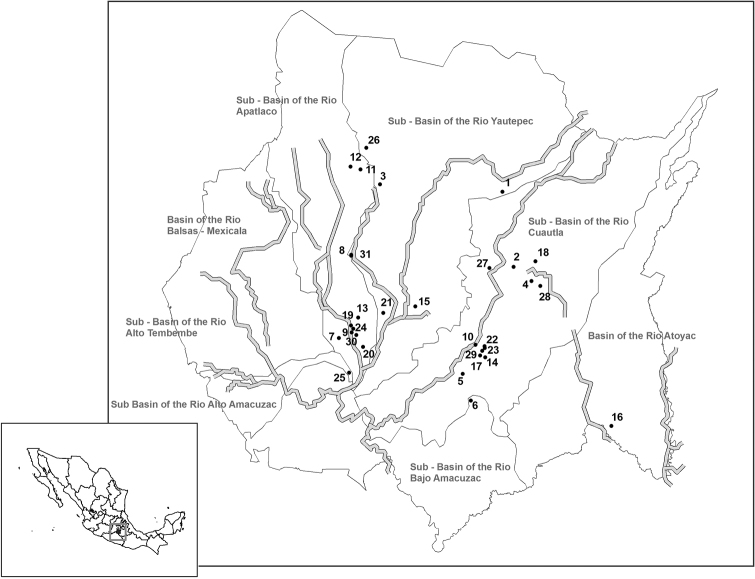
Map of the state of Morelos, Mexico showing position of each APU: 1 7 Hermanos (18°51'49.82132"N; 98°58'01.20211"W2 Acuícola Ayala (18°45'11.59525"N; 98°56'58.87989"W) 3 Acuícola de Jiutepec (18°52'29.84116"N; 99°09'24.49751"W) 4 Acuícola Jaloxtoc (18°43'56.72740"N; 98°55'20.14003"W) 5 Adilene Marisol (18°35'43.94208"N; 99°01'43.49419"W) 6 Agua Fría (18°33'22.41096"N; 99°00'57.44948"W) 7 Aquafish (18°38'53.20757"N; 99°13'13.80019"W) 8 Betta Fish (18°46'15.00012"N; 99°12'05.44263"W) 9 Centro Zacatepec (18°39'22.70079"N; 99°12'02.36030"W) 10 Centro de Acopio La Perla (18°38'18.23968"N; 99°00'32.15165"W) 11 Consorcio Lugo-Galeana (18°53'48.34681"N; 99°11'13.92251"W) 12 El Chino (18°54'03.35178"N; 99°12'10.27438"W) 13 El Cifón (18°40'42.68111"N; 99°11'26.16448"W) 14 El Invernadero (18°37'11.86468"N; 98°59'37.85120"W) 15 Exopez (18°41'41.78829"N; 99°06'07.81780"W) 16 Granja Acuícola Foras (18°31'07.09460"N; 98°47'54.39963"W); 17. Grupo Carsal (18°37'21.23567"N; 99°00'05.49462"W) 18 Huertas de Cuatla (18°45'41.45252"N; 98°54'57.10516"W) 19 Jesús Madariaga (18°39'59.91903"N; 99°12'05.85187"W) 20 La Buena Fortuna (18°38'07.31312"N; 99°10'58.58424"W) 21 La Cascada (18°41'06.91860"N; 99°09'05.97650"W) 22 Linda Vista (18°38'11.27728"N; 98°59'41.36454"W) 23 Los Huajes (18°38'01.06064"N; 98°59'39.86312"W) 24 Maleny (18°39'43.43675"N; 99°11'52.86078"W) 25 Maricultura Argos (18°35'50.18775"N; 99°12'16.44262"W) 26 Olascoaga (18°55'43.39346"N; 99°10'40.92078"W) 27 Ornapez (18°45'06.02177"N; 98°59'14.37030"W) 28 Platanar (18°43'30.25259"N; 98°54'30.22690"W) 29 Pliego (18°37'45.93123"N; 98°59'53.99321"W) 30 San Tilapia (18°39'09.51796"N; 99°11'36.53955"W) 31 Tropipez (18°46'10.83544"N; 99°12'05.47184"W).